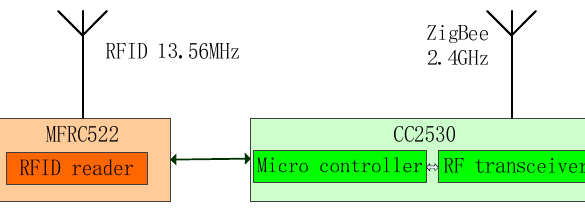
Figure 3. Block diagram of the RFID reader/router.